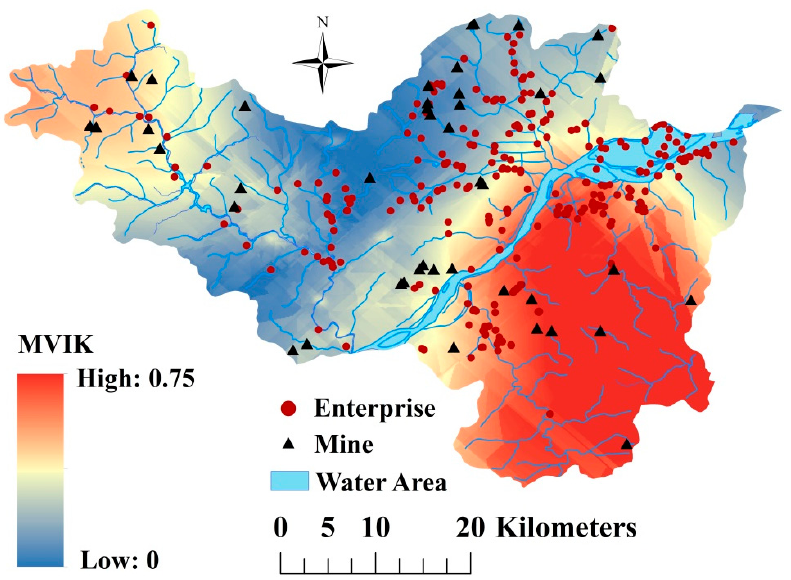
Figure 6. Spatial distribution of multi-heavy metals pollution risk produced by Multi-variables Indicator Kriging (MVIK).